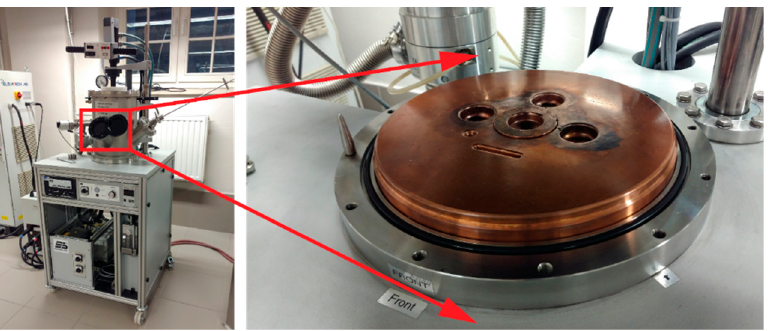
Figure 1. Laboratory arc furnace (arc ‐ melter) from Edmund Bühler GmbH. In the middle of the copper plate is a suction casting mold and around it are milled recesses for remelting the elements.